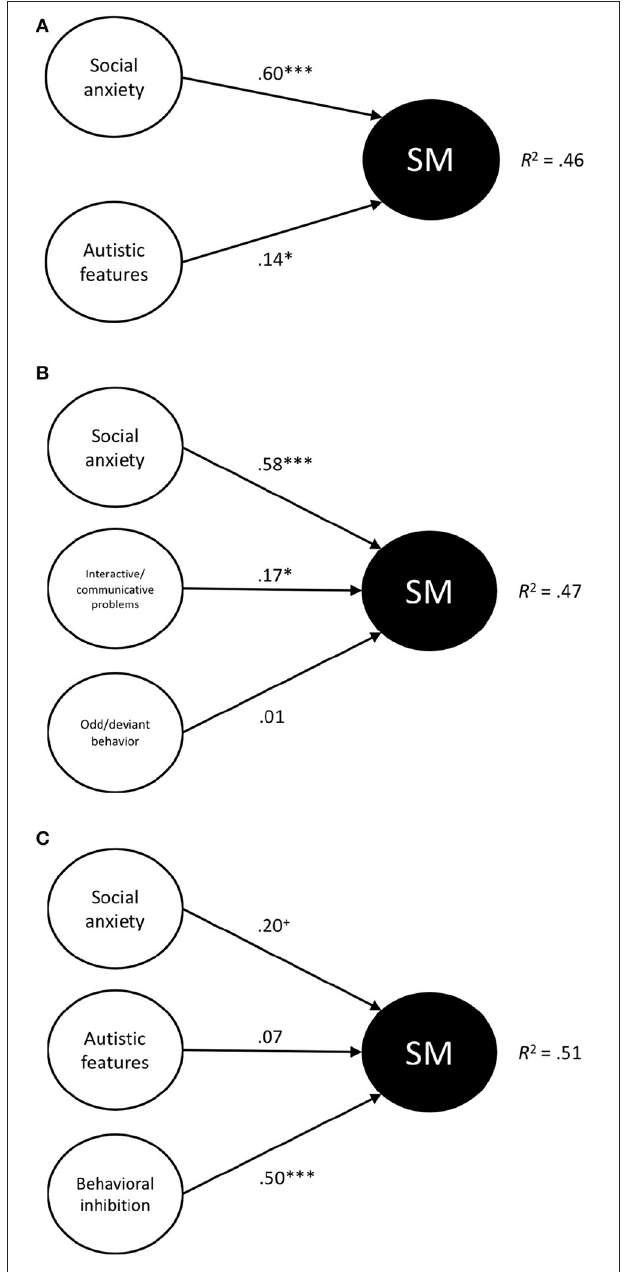
FIGURE 1 | (A–C) Schematic representation of the three regression models that were tested. Standardized betas and R 2 values are shown.